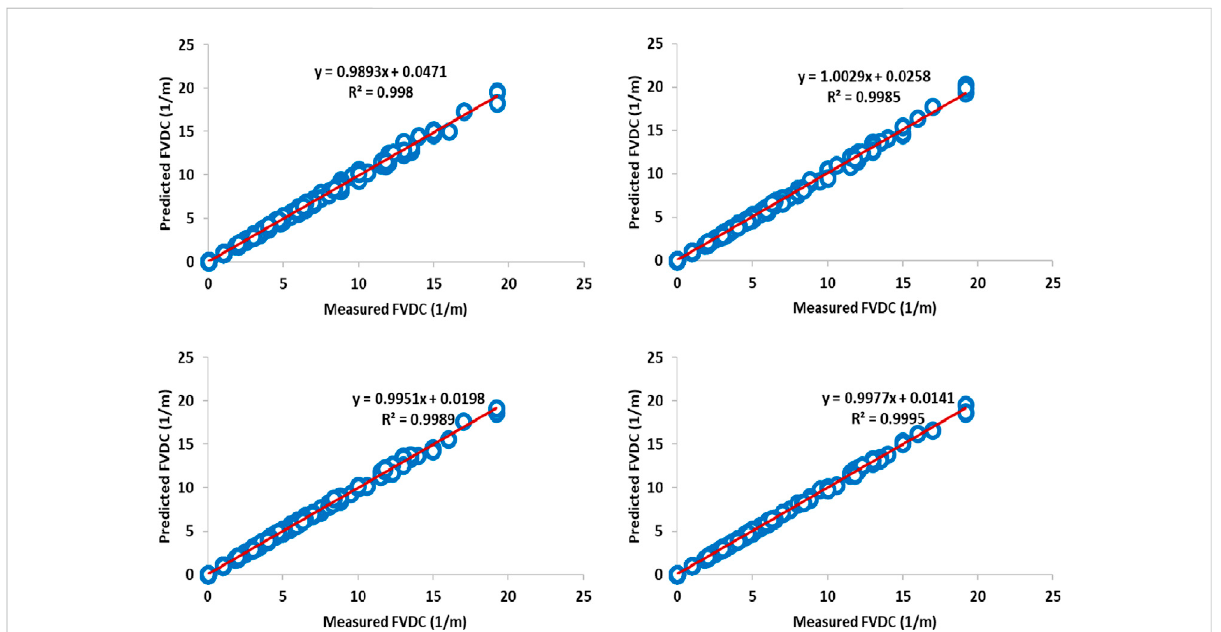
FIGURE 11 llustration of cross plot for training subset (70% ~ 2049 data point) based on four roboust hybrid machine learning LSSVM-PSO, LSSVM-GA, MLP-PSO and MLP-GA based on dataset of well #W1.